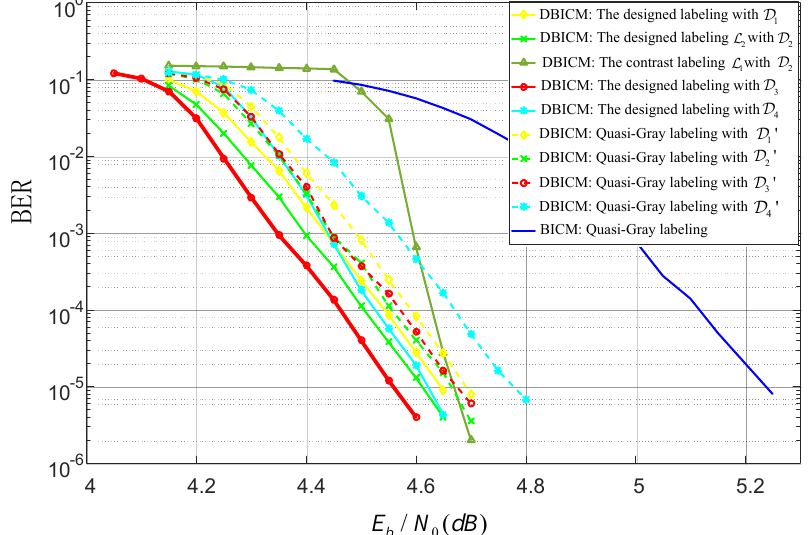
Figure 7. BER performance with code rate 0.5.